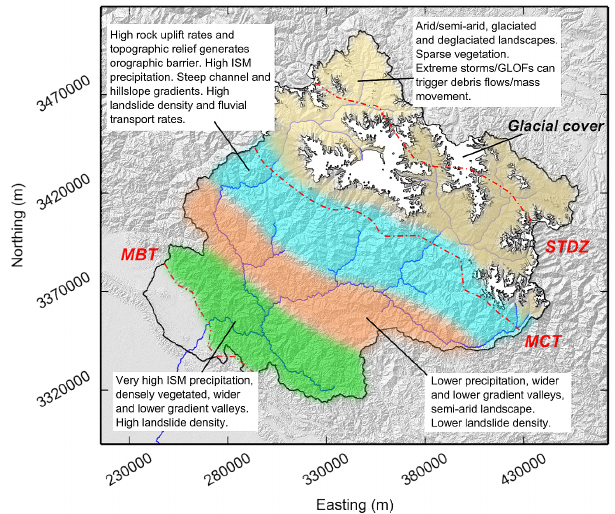
Figure 2. Broad distribution of geomorphic process domains across the Ganga catchment. The approximate positions of the Main Boundary Thrust (MBT), Main Central Thrust (MCT) and South Tibetan Detachment Zone (STDZ) are shown by red dashed lines following Ray and Srivastava (2010). Relative landslide density was determined by manual mapping of > 400 landslides across the Ganga catchment using Google Earth imagery, where landslides in glacially influenced parts of the catchment were excluded. ISM de- notes the Indian Summer